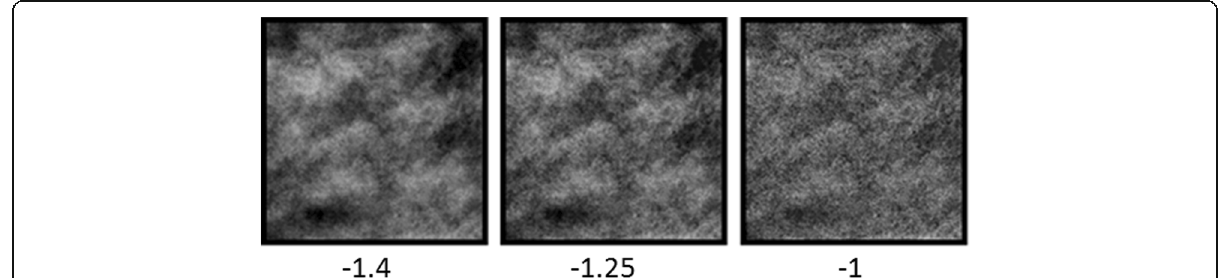
Fig. 3 Still images illustrating blur after-effects in the images (the animated version of this figure is available to view in Additional file 1). The three adapting images with slopes of − 1.4, − 1.25, or − 1 are shown for 3 s, alternated with three test images all with the same slope of − 1.25 shown for 1 s. The after-effects are best experienced by continuously fixating the center image. The test images on the left and right should appear sharper and blurrier, respectively, relative to the central test